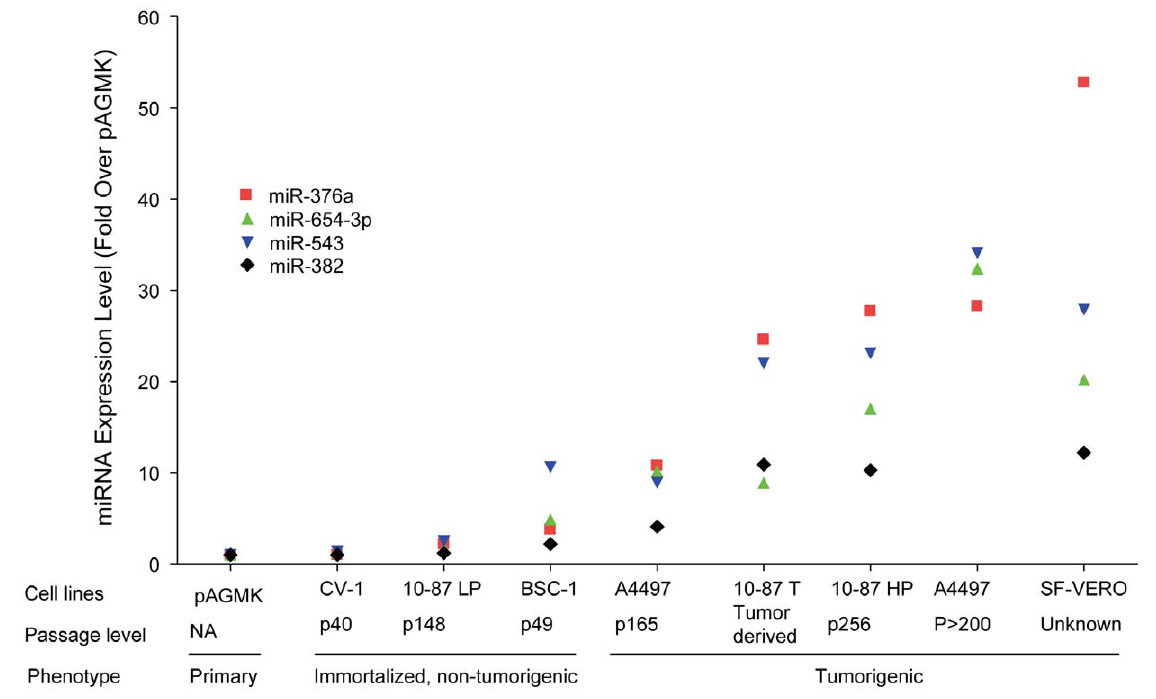
Figure 5. Correlation between expression of miRNAs and the neoplastic phenotype. The qRT-PCR values of over-expressed miRNAs (Table 3) were used to locate on the X-axis the position of seven lines of immortalized AGMK cells relative to pAGMK cells. Based on the relative magnitude of the expression levels of these miRNAs compared with their expression levels in pAGMK cells, the non-tumorigenic CV-1 cells were the closest and the tumorigenic SF-VERO cells were the most distantly removed from pAGMK cells (the reference point for the non-tumorigenic phenotype). When the in vitro and in vivo characteristics of all cells were superimposed, the trend in miRNA expression in the different AGMK lineages between CV-1 and SF-VERO cells on the X-axis appears to correlate with both the passage level in tissue culture and the evolution of the neoplastic process. The phenotypes were deduced from Table 1 and the data from the invasion assays.